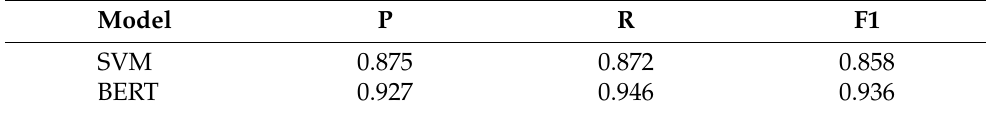
Table 6. Classification results obtained from BERT model with comparison to